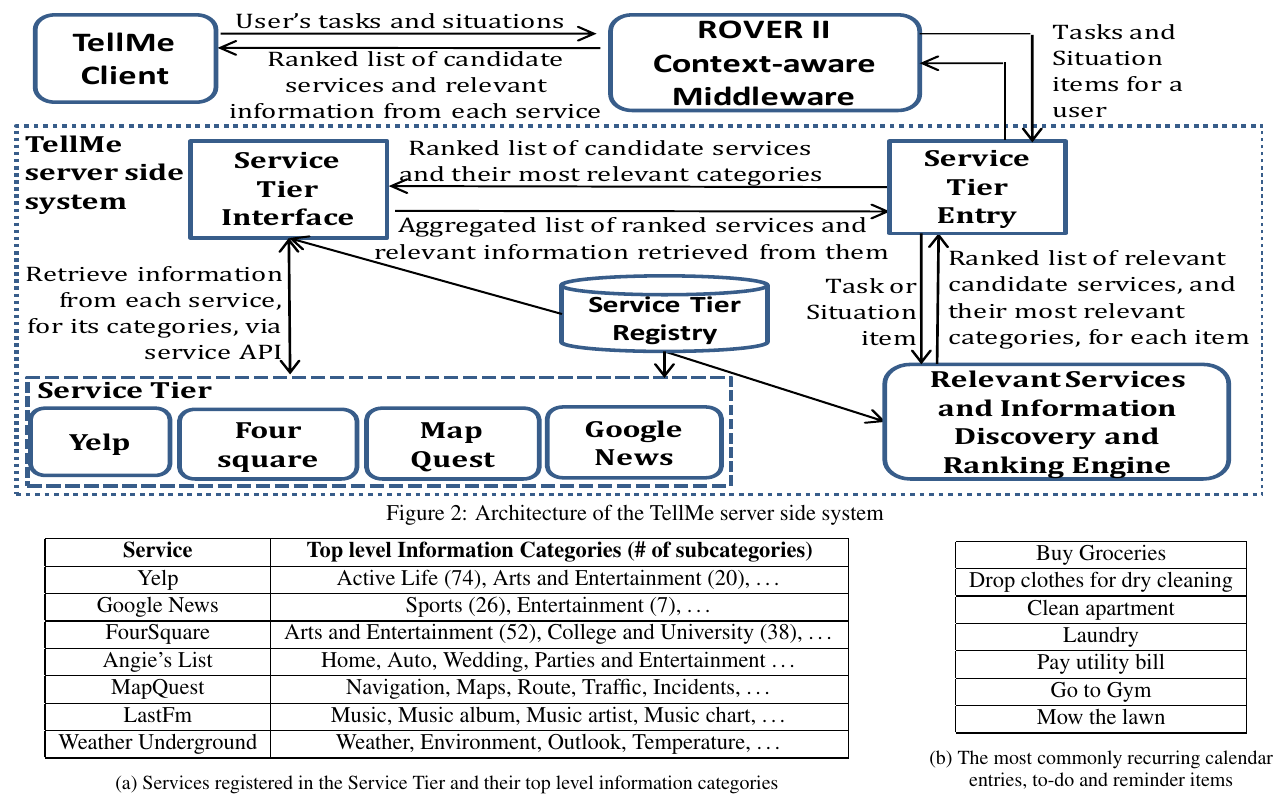
Table 1: Services and their categories, as well as the most common situation items collected as part of our